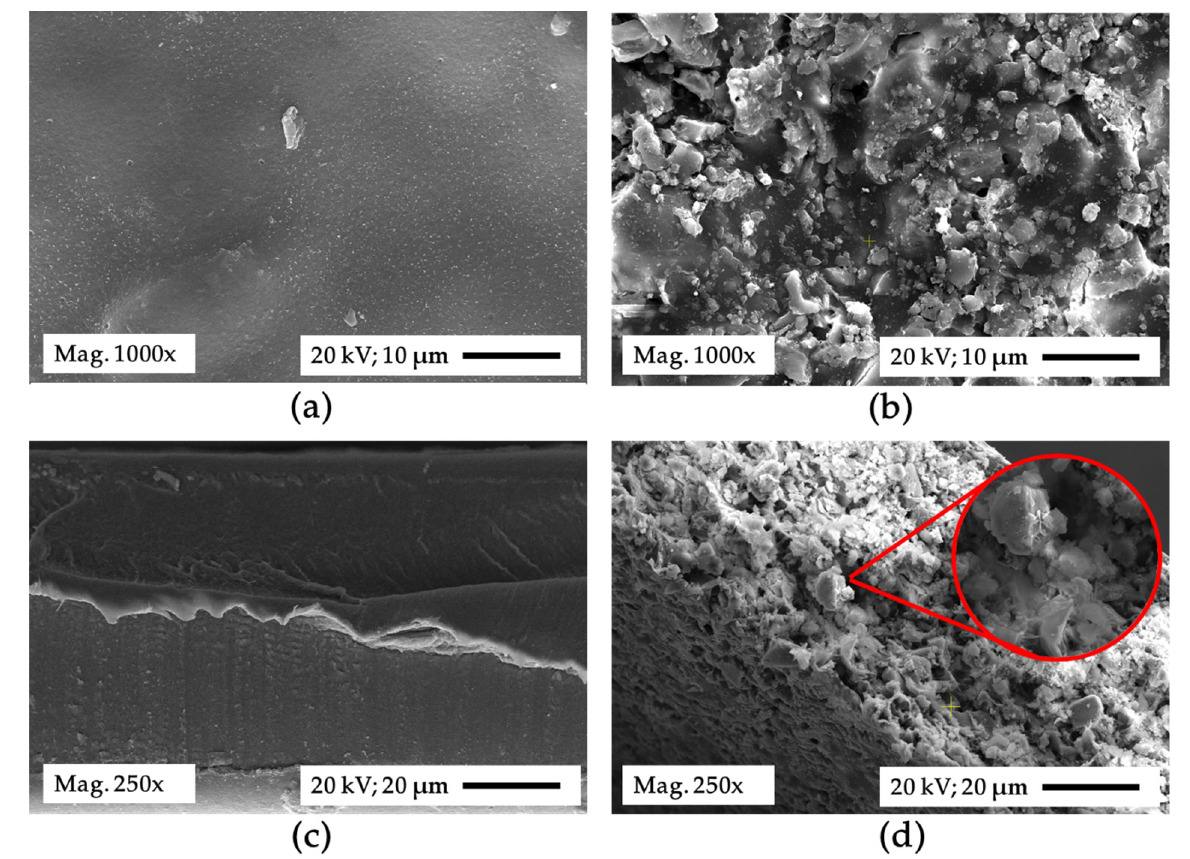
Figure 3. Surface images of chitosan ( a ) and the prepared IOCM (60% silica) ( b ). Cross-section images of chitosan ( c ) and IOCM (60% silica) ( d ). Surface and cross-section images were observed under SEM with 1000 × and 250 × magnifications. Highlight in red in the cross-section image of IOCM shows its appearance in 750 × magnification.